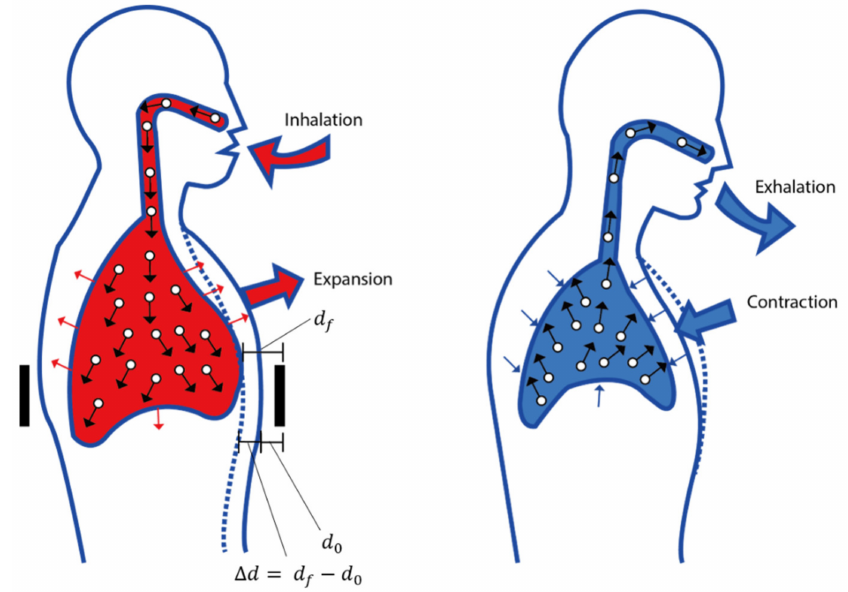
Figure 5. Changes in the abdomen size and the amount of air in the lungs due to